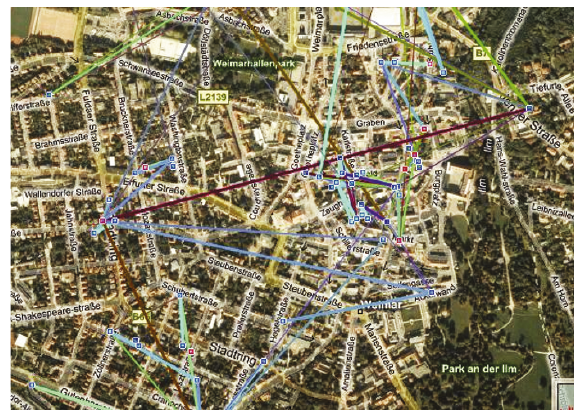
Figure 7: Map of Weimar Freifunk